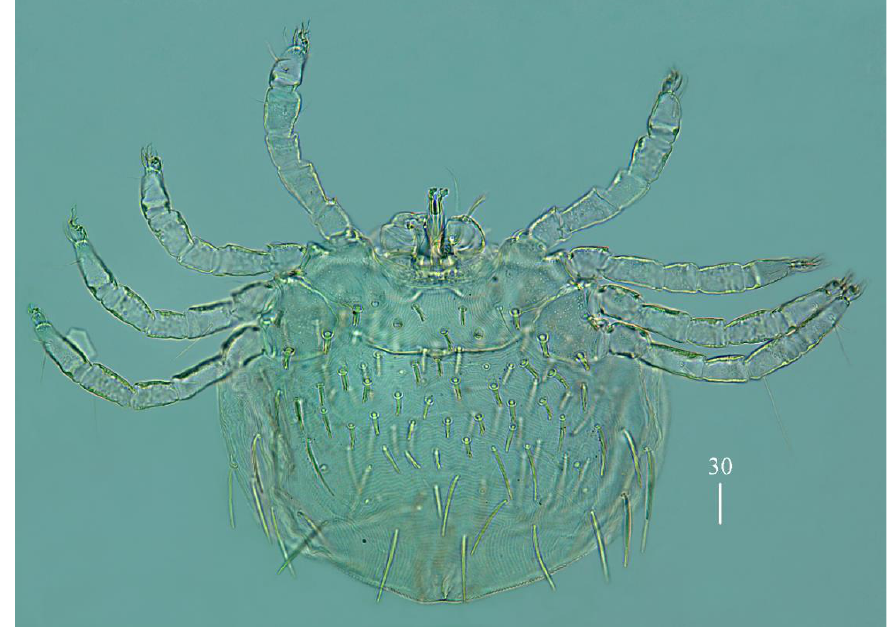
Figure 4. Geckobia gigantea sp. n. deutonymph in ventral view.